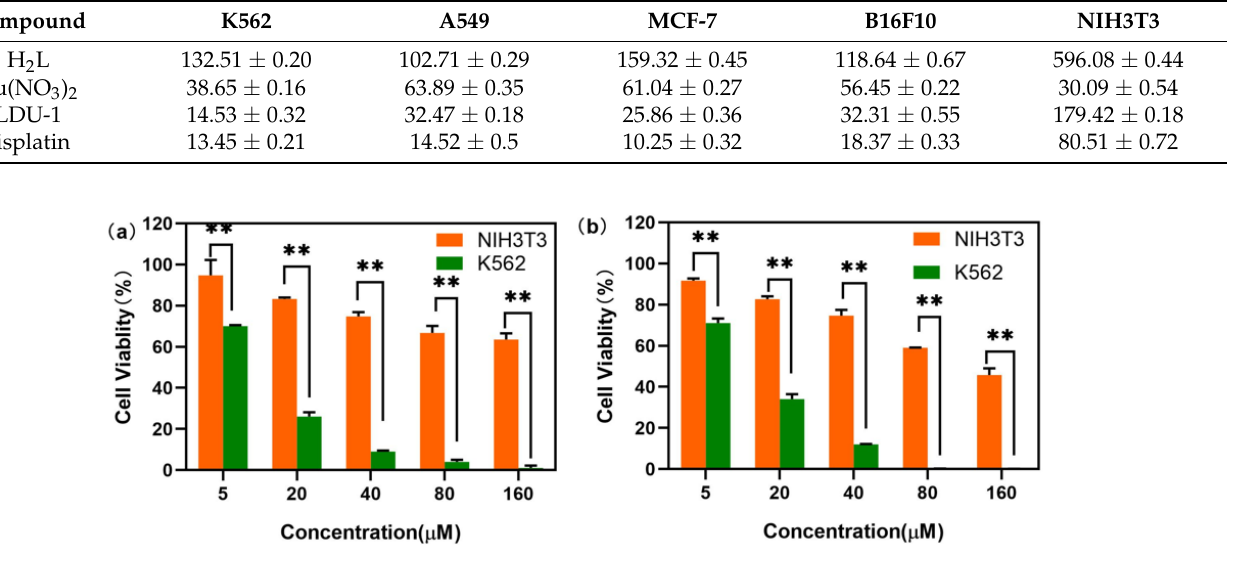
Figure 4. Cell viability of NIH3T3 and K562 cells after incubation with LDU ‐ 1 at various concentra